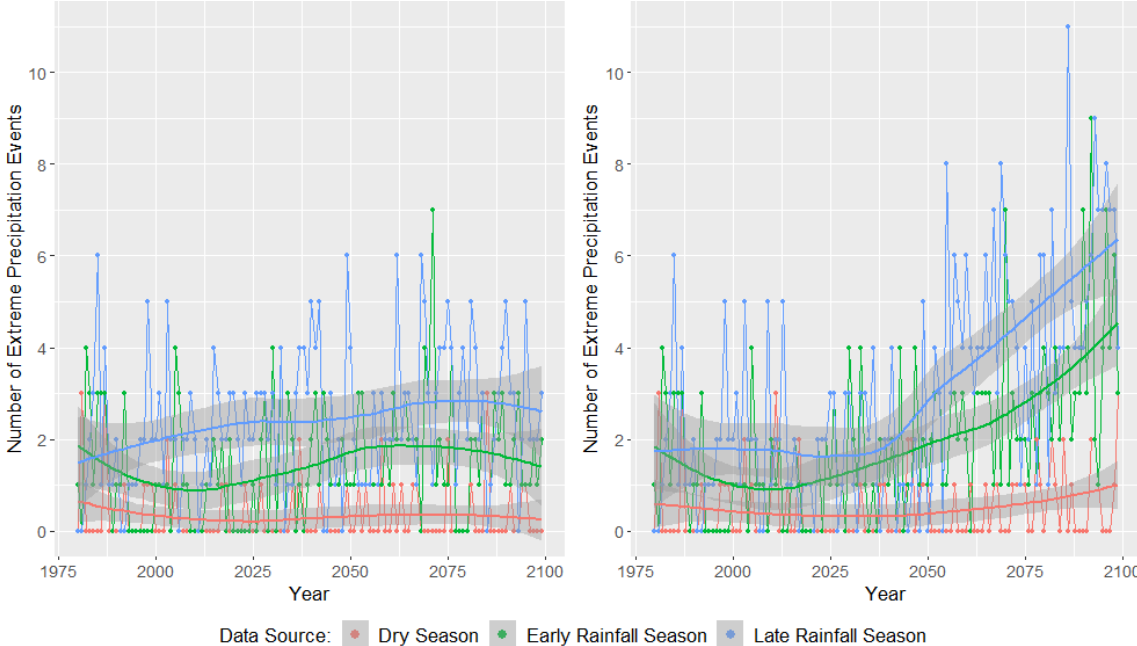
Figure C4. Total number of ER events (island daily average rainfall > 29 . 90mm) by season for the HadGEM2’s RCP4.5 forcing scenario (left) and the RCP8.5 forcing scenario (right). Historical GHCN observations are also indicated on these plots (1980–2005). This figure was created using Wickham (2016).